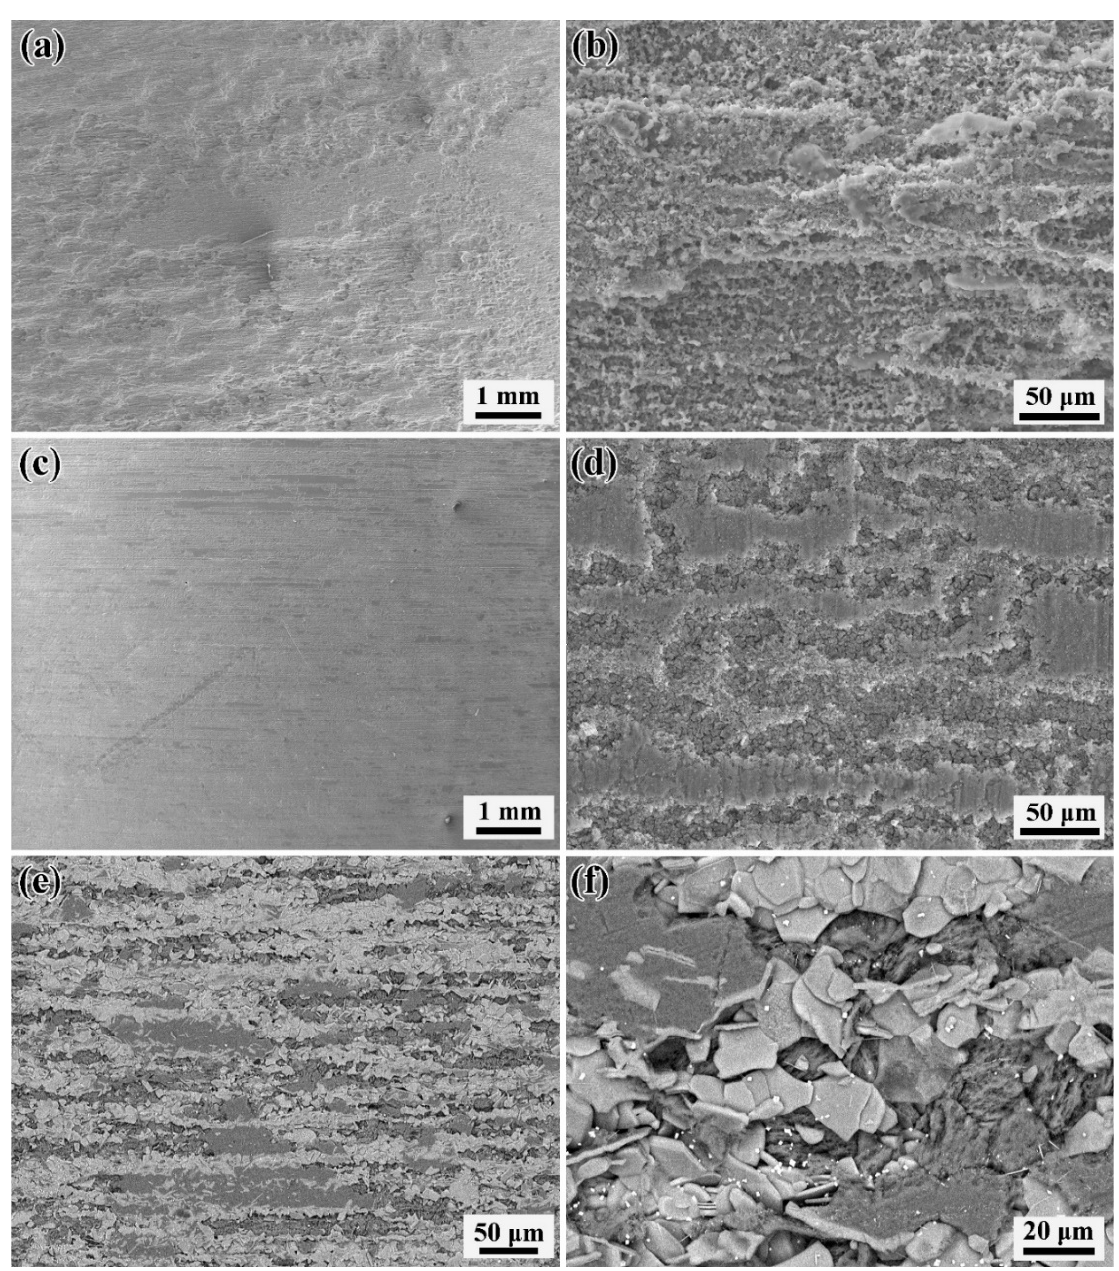
Figure 6. Microscopic corrosion morphology under SEM after immersion in 3.5% NaCl solution saturated with Mg(OH) 2 for 24 h: ( a , b ) As-extruded sample; ( c , d ) T5 sample; ( e , f ) T6